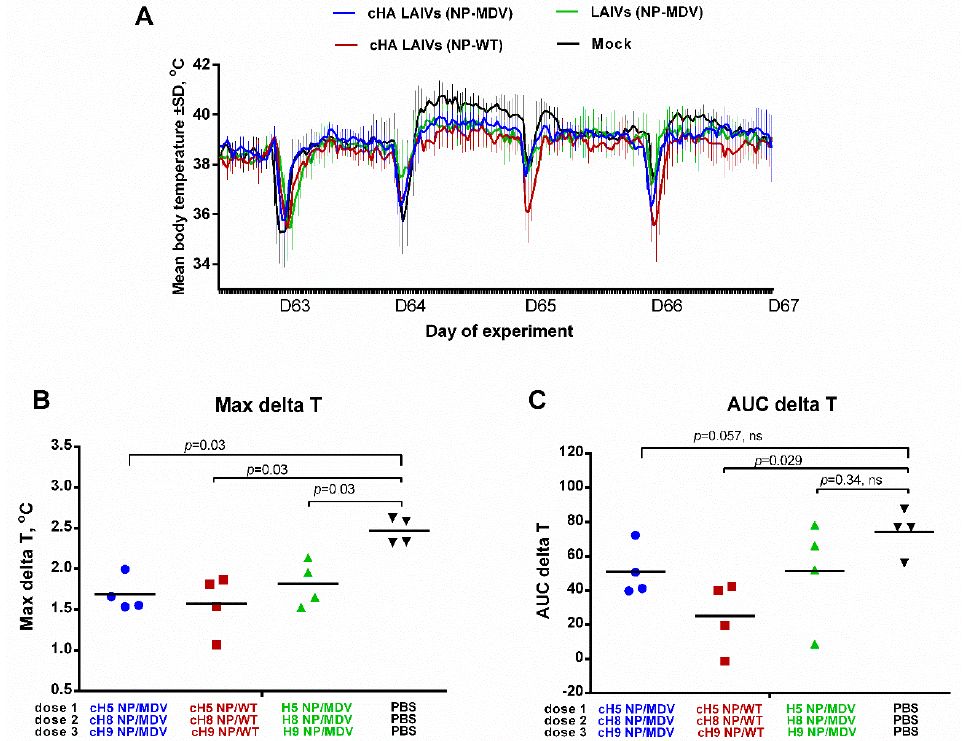
Figure 10. Body temperature of immunized ferrets after challenge. ( A ) Variation in body temperature over the challenge phase. The several sharp decreases in temperature are the result of sedation during challenge (D63) and collection of nasal wash fluids. ( B ) Maximal increase in body temperature over the challenge phase. ( C ) Area under the curve of delta T relative to baseline temperature for each ferret over the challenge phase. Statistical differences with mock-vaccinated group are indicated (Mann-Whitney U test); ns = not significant.